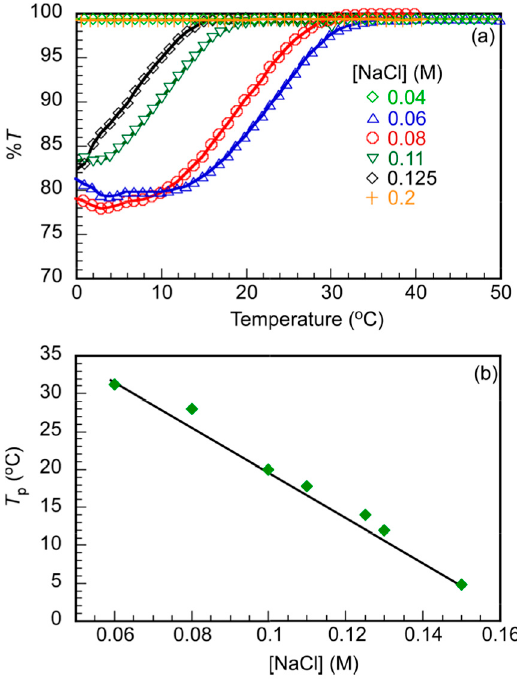
Figure 8. ( a ) Percentage transmittance (% T ) of PSBP/CTAB complex aqueous solutions at a complex concentration of 0.084 g/L with a mixing ratio of 0.5 at different [NaCl], as a function of temperature after the cooling process and ( b ) [NaCl] dependence of the phase transition temperature ( T p ) for the PSBP/CTAB complex.